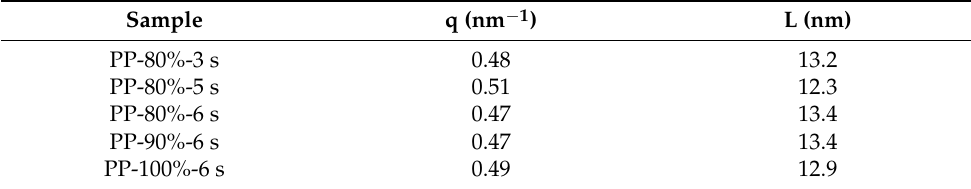
Table 3. Scattering vector (q) and long-period (L) values obtained from 1D-SAXS patterns for various UMIM